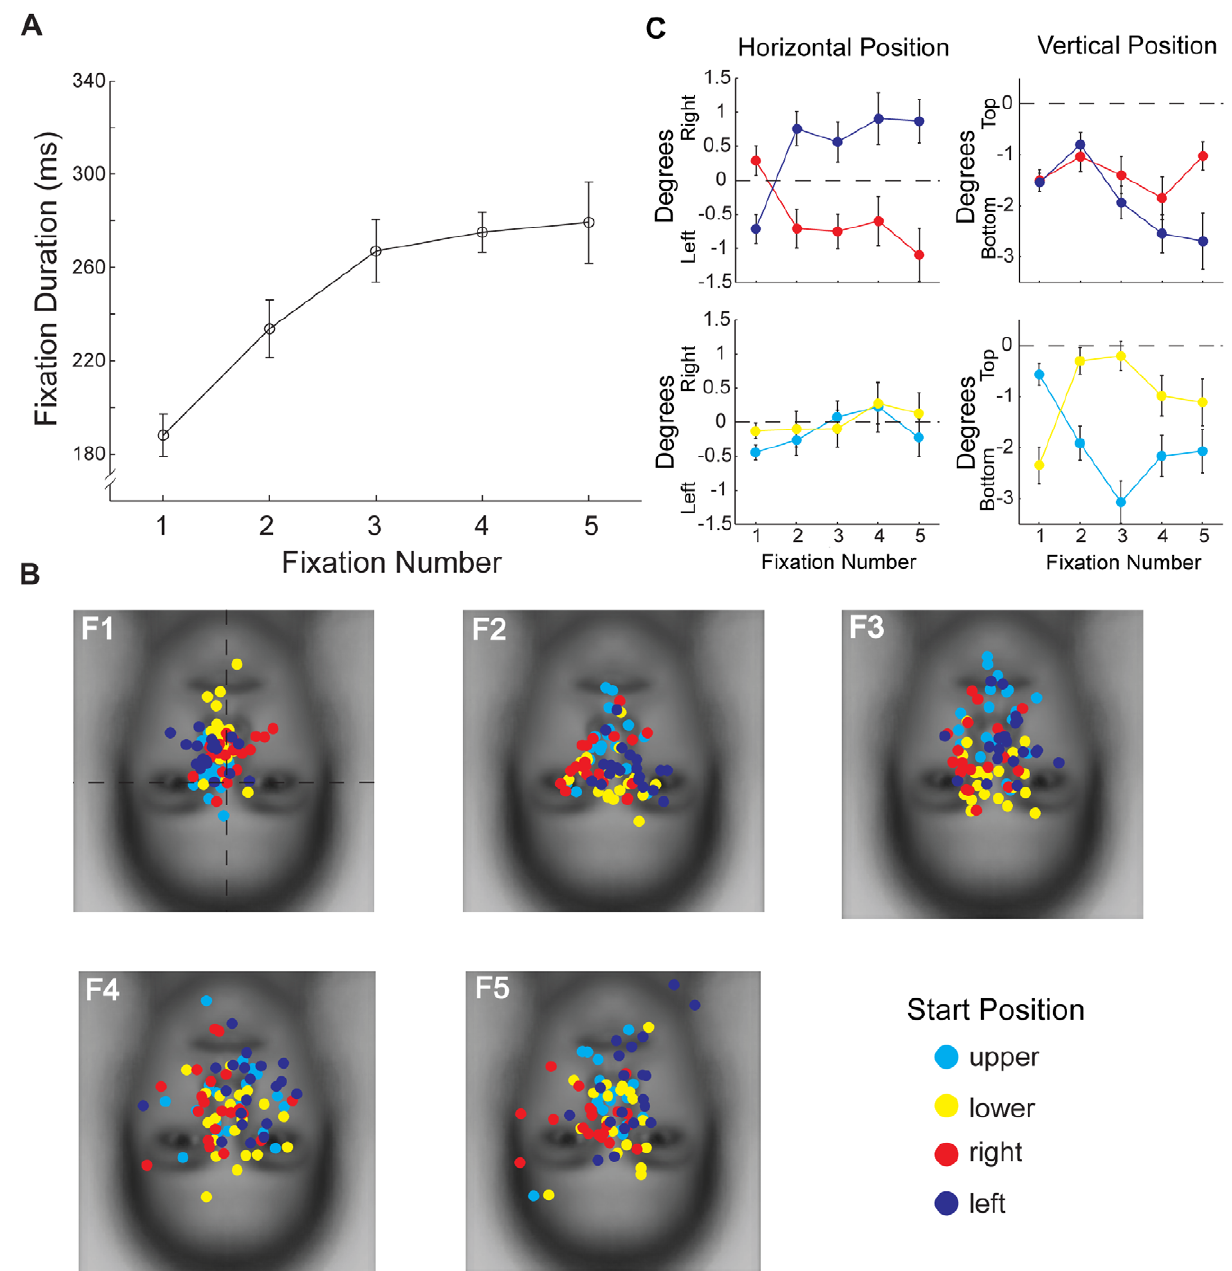
Figure 9. Evolution of fixations over ordinal number for inverted faces. ( a ) Average duration of each ordinal fixation. Note the much shorter duration of the first than subsequent fixations as was observed for upright faces. ( b ) Distribution of fixation locations across individual participants broken down by start position for each ordinal fixation (F1–F5). As for upright faces, fixation locations for the first fixation were generally toward the center of the face, but with a relative tendency to fall closer to the start position. Subsequent fixations locations tended to fall on the side of the face opposite the start position just as for upright faces. Note that all start positions are defined relative to the face. ( c ) Average locations from (b). Note the similar effects to those shown in Figure 6c. Error bars indicate the between-subjects standard error. doi:10.1371/journal.pone.0031106.g009 second and subsequent fixations. The horizontal difference in a tendency toward the start position (Figure 9b). Thus, first fixation location between the left and right start positions was fixations for the left start position were significantly to the left of significant for fixations 2–5 (all t . 3.46, p , 0.01), and the vertical those for the right start position (t =3.09, p , 0.01), and first difference between the upper and lower start positions was fixations for the lower start position were significantly lower than significant on fixations 2–4 (all t . 3.60, p , 0.002) (Figure 9c). first fixations for the upper start position (t= 4.98, p , 0.001). As with upright faces, the central tendencies for each start position Direct comparison of the spatial density maps for the right and switched to the side of the face opposite the start position on the left start positions across fixations 2–5 revealed a similar pattern to